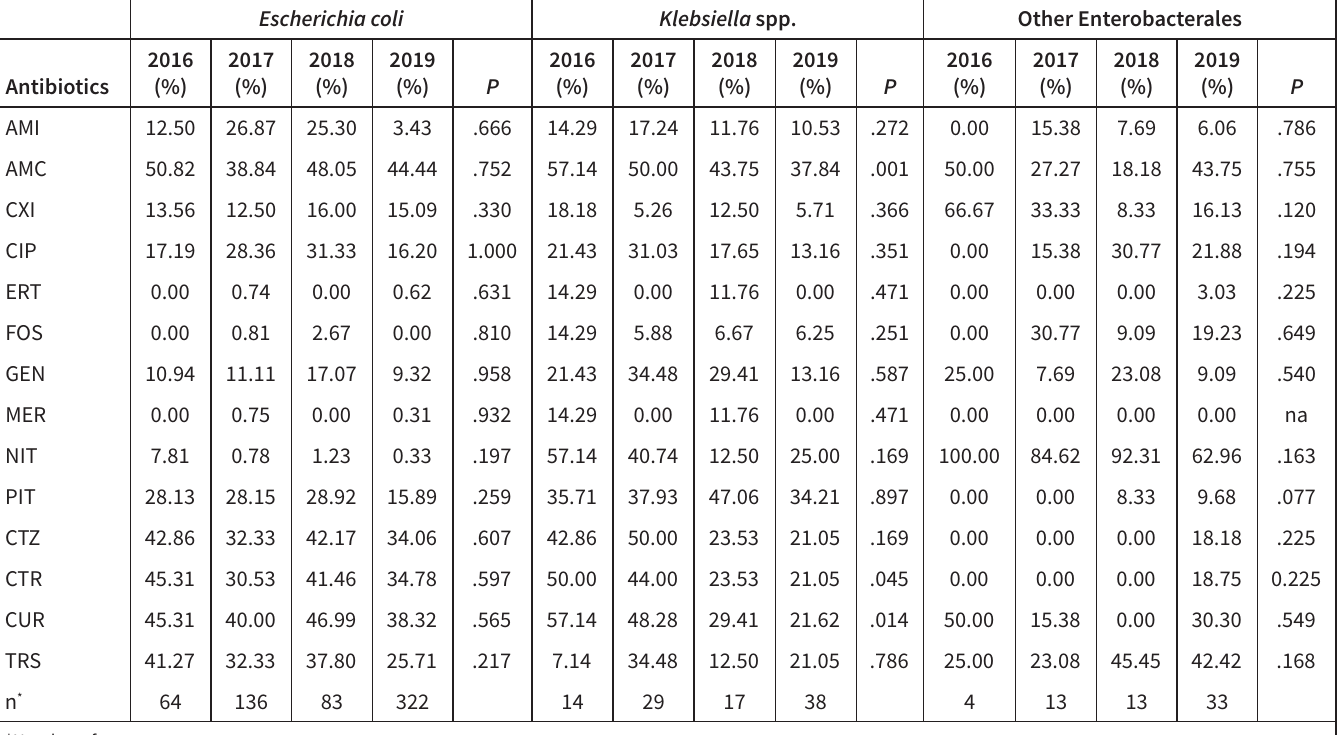
Table 4. Trends in Antibiotic Resistance Rates of Escherichia coli, Klebsiella spp., and the other Enterobacterales Escherichia coli Klebsiella spp. Antibiotics AMI 12.50